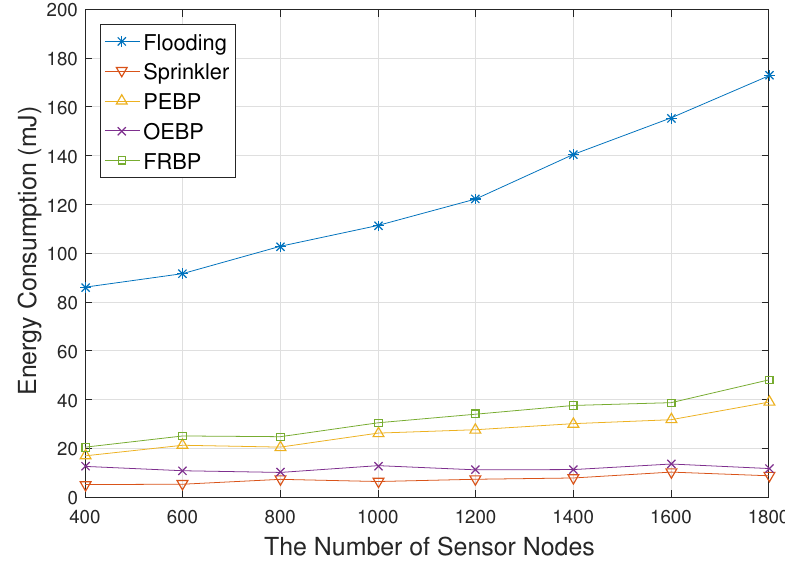
Figure 4. Average energy consumption impacted by the number of